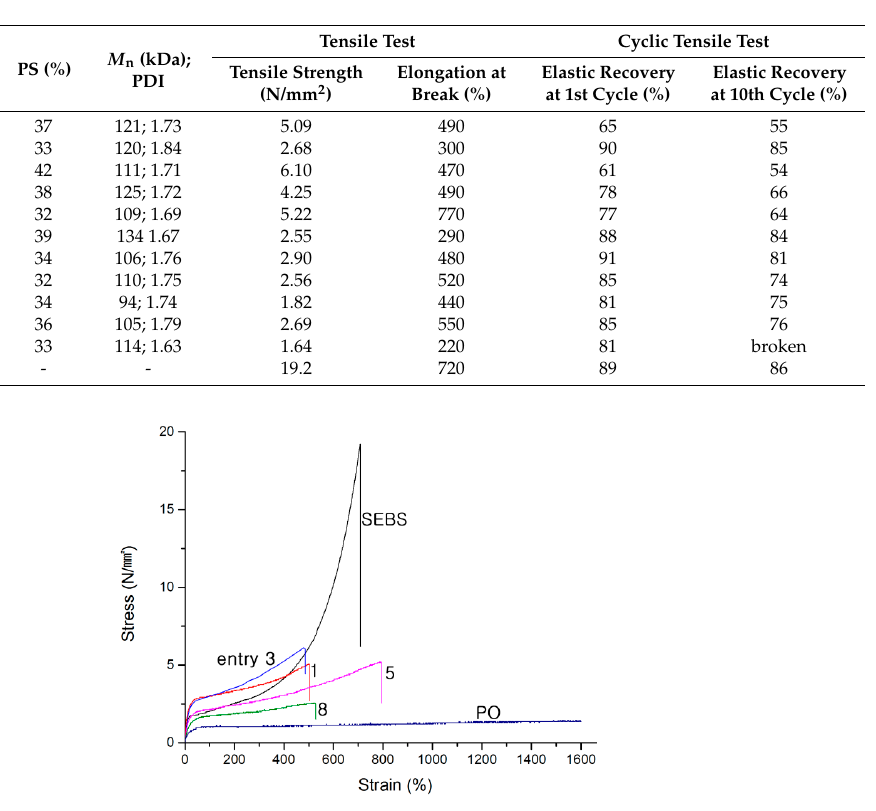
Table 2. Results of the tensile test and the cyclic tensile test.